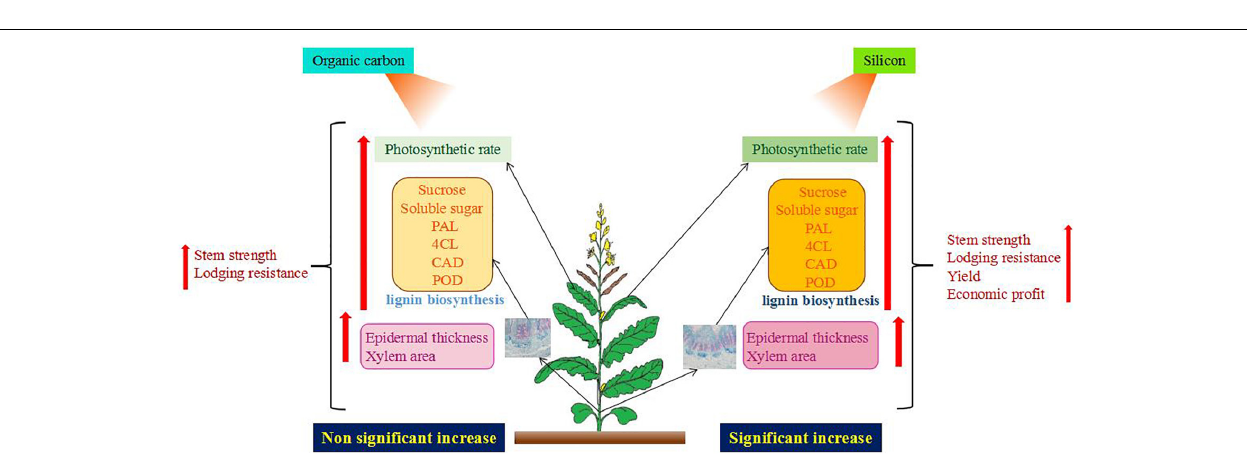
FIGURE 9 | Effect of organic carbon and silicon fertilizer on plant characteristics of